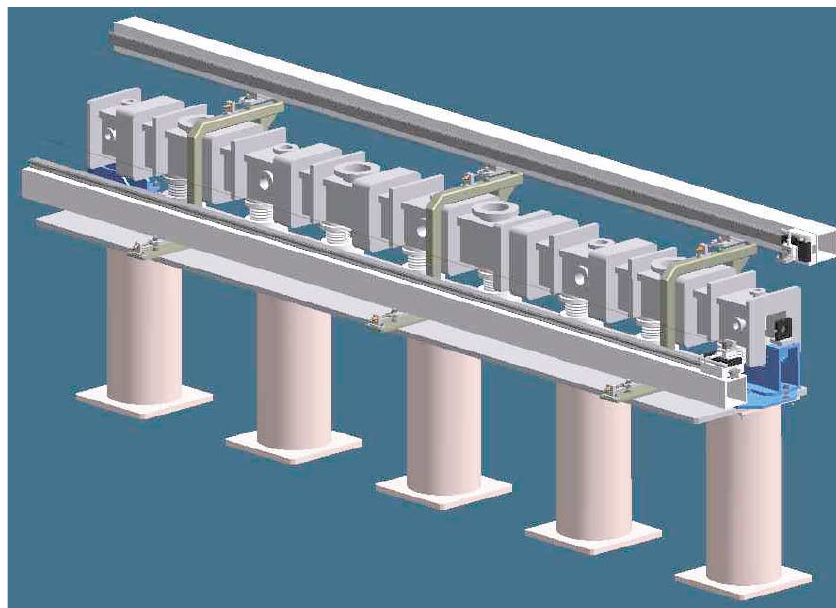
FIG. 9. (Color) Computer-aided design drawing of the VISA undulator vacuum vessel, support table, and rails for the straightness interferometer measurements. The thick square objects around the vessel represent iron-core window-frame steering correction magnets. The thin square objects represent stiffeners that were not ultimately employed. In the final implementation, the vessel was supported near the Airy points, not at the ends. Large ports on top are for pumping, and small ports on the top and sides are for alignment